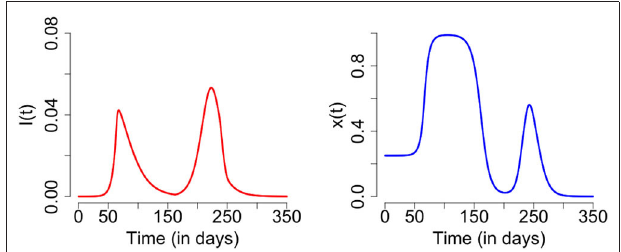
FIGURE 1 | Second wave of COVID-19: time series plot of the number of infected individuals (left) and proportion of individuals practicing physical distancing (right) . The results are obtained for C 0 = 0.63, R 0 = 2.675, 1 /σ = 2.5, γ = 1 / 5, κ = 5, ǫ = 0.008, α = 1.0 ∗ 24 / 365, and δ = 0.05 ∗ 24.0 / 365 and initial conditions S (0) = 1 − 1 / 1000000, E (0) = 0, I (0) = 1 / 1000000, R (0) = 0, x (0) = 0.25, L (0) = 0, and H (0) = 0.